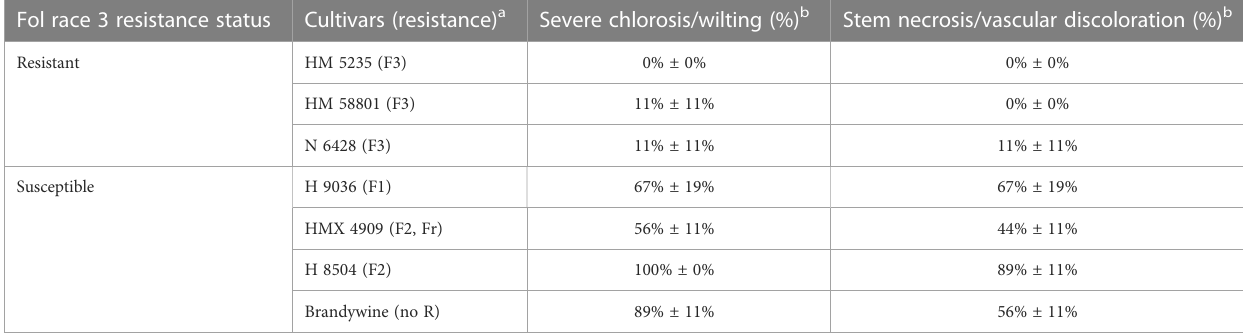
TABLE 7 Fusarium wilt development in resistant (F3) cultivars under greenhouse conditions.